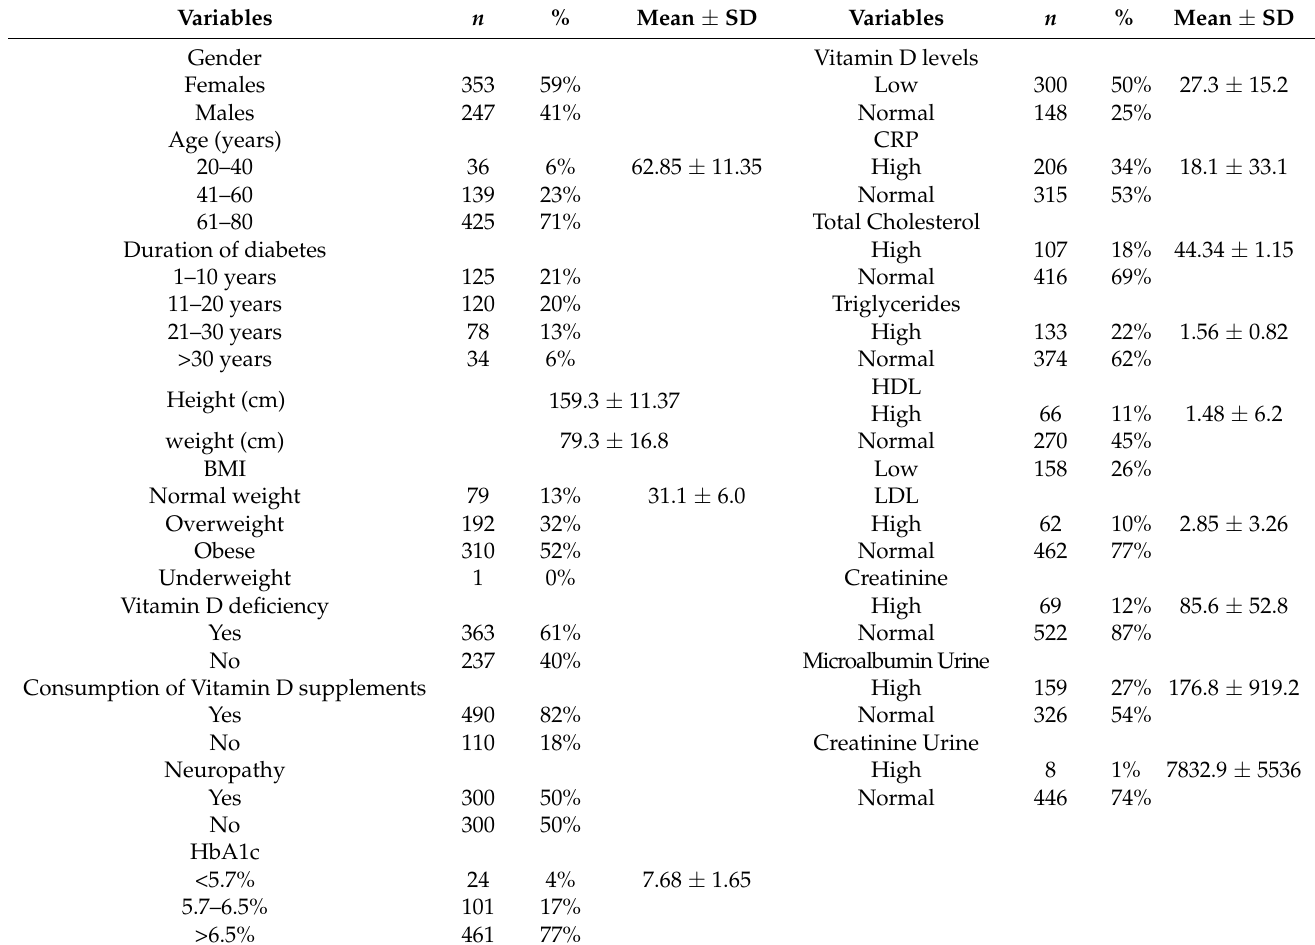
Table 1. Basic anthropometric, clinical characteristics and Vitamin D supplement consumption of patients ( n =